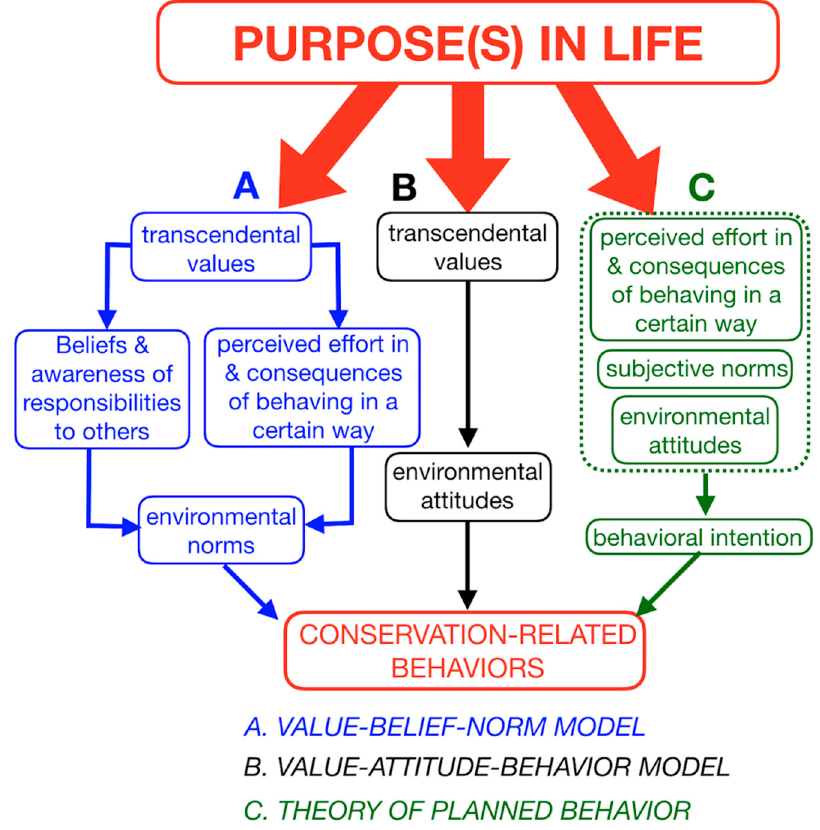
Figure 2. Some models used in conservation psychology to understand behavior. Many, though not all, such efforts make explicit use of transcendental values (or means-oriented values, Figure 1). Transcendental value is commensurable with the concept, virtue, as used in academic ethics. Model (A) can be depicted with additional mediating steps, i.e., values → value orientations → attitudes & norms → behavioral intentions → behaviors . The explanatory power of models in conservation psychology may well be extended by taking account of the purpose(s) in life to which one ascribes. In other words, ends-oriented values may be more important than generally appreciated. The important of purpose is highlighted by virtue ethics (see Section 3). For a more detailed review of these models, see Klöckner [45].